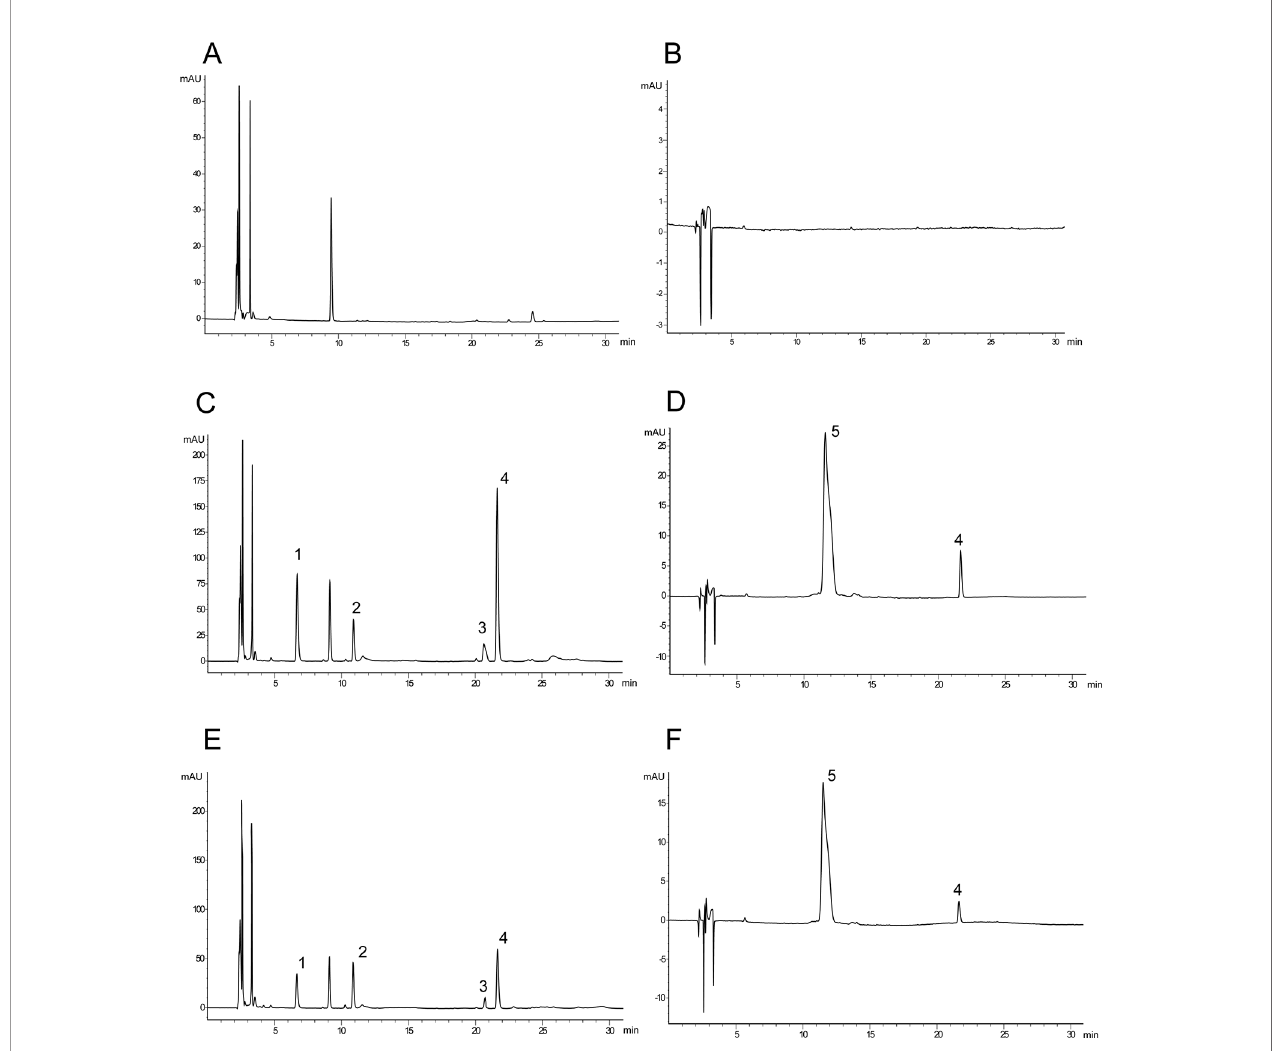
FIGURE 2 | Typical chromatograms of rat plasma. (A) Blank serum sample (280 nm); (B) blank serum sample (403 nm); (C) blank serum sample spiked with danshensu (DSS), hydroxysaf fl or yellow A (HSYA), salvianolic acid B (SAB), salvianolic acid A (SAA), and internal standard (IS) (280 nm); (D) blank serum sample spiked with HSYA and p -hydroxybenzoic acid (403 nm); (E) after 10 minutes of administration (280 nm); (F) after 10 minutes of administration (403 nm) (1: DSS; 2: p -hydroxybenzoic acid (IS); 3: SAB; 4: SAA; 5: